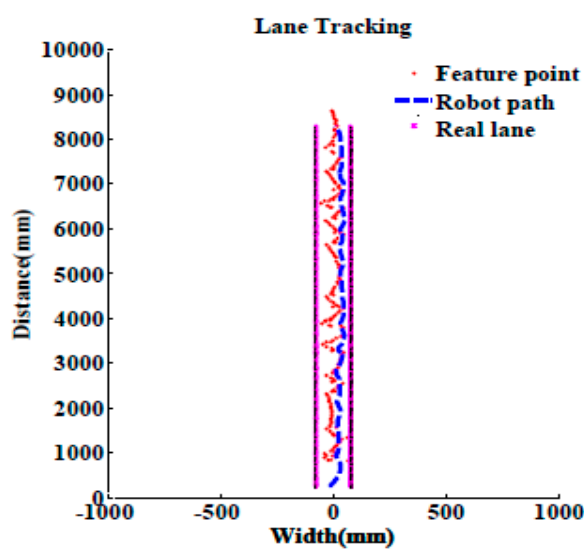
Figure 13. Result of lane tracking test.